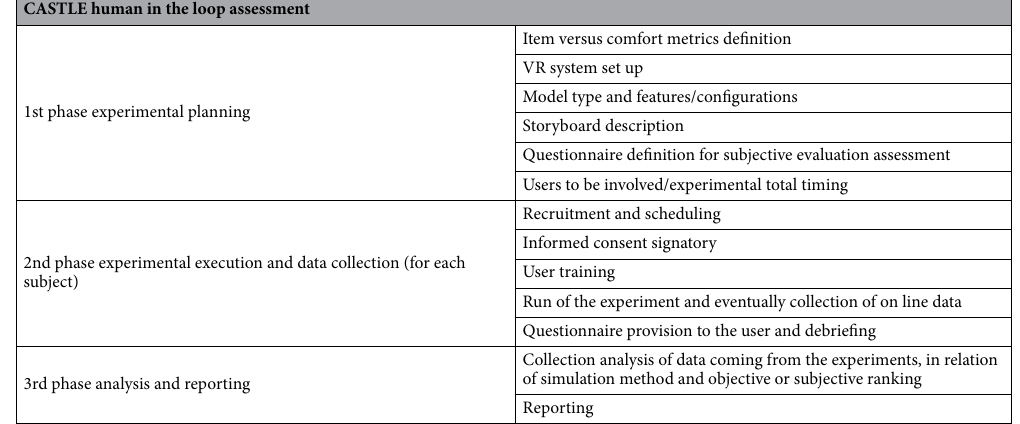
Table 1. Description of the processes for the human in the loop experiments in VR.